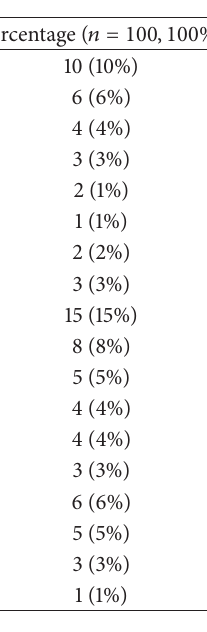
Table 2: Type distribution of detected respiratory viruses and